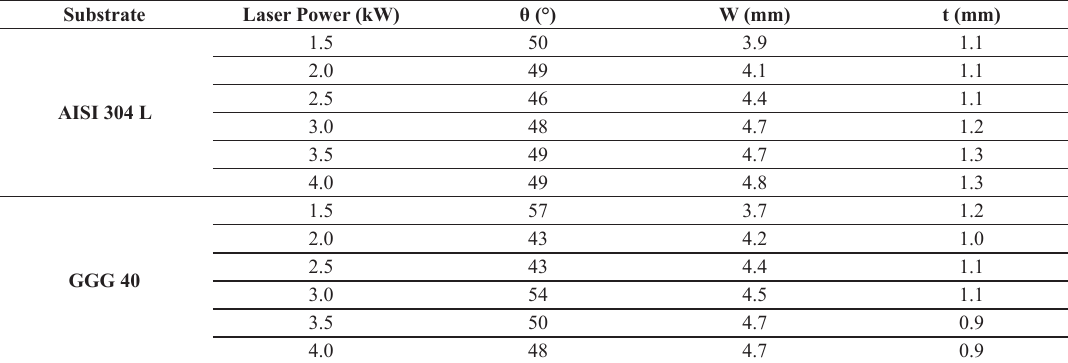
Table 3. Wettability angle (θ), bead width (W) and reinforcement thickness (t) measurements for all laser power tested on both substrates. Substrate